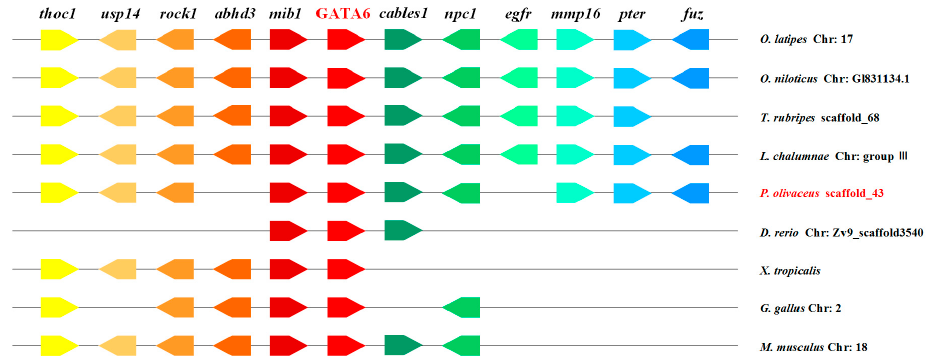
Figure 5. Chromosome synteny of GATA6 of P. olivaceus with that of other vertebrates. The pentagons with different colors represent various genes and their respective direction. Gene order was determined according to the relative position of genes in the same chromosome or scaffold. Chr, chromosome.